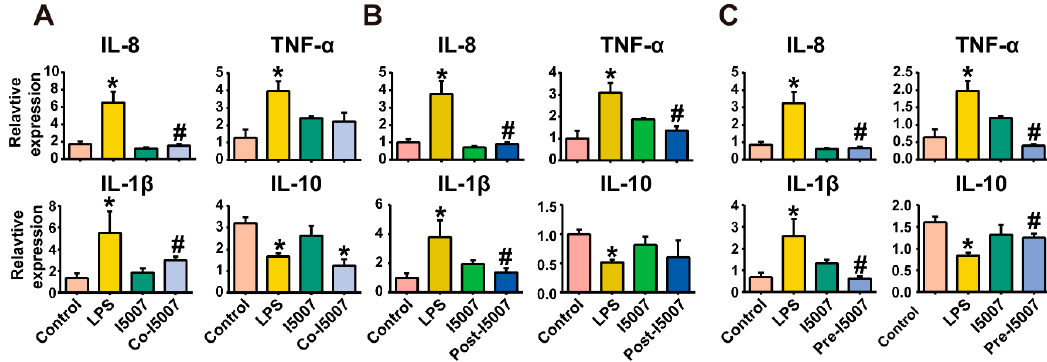
Figure 1. Induction of inflammatory cytokine expression in HT ‐ 29 cells upon treatment with lipopolysaccharides (LPS) and L. reuteri I5007. ( A ) Cotreatment. HT ‐ 29 cells were challenged with L.